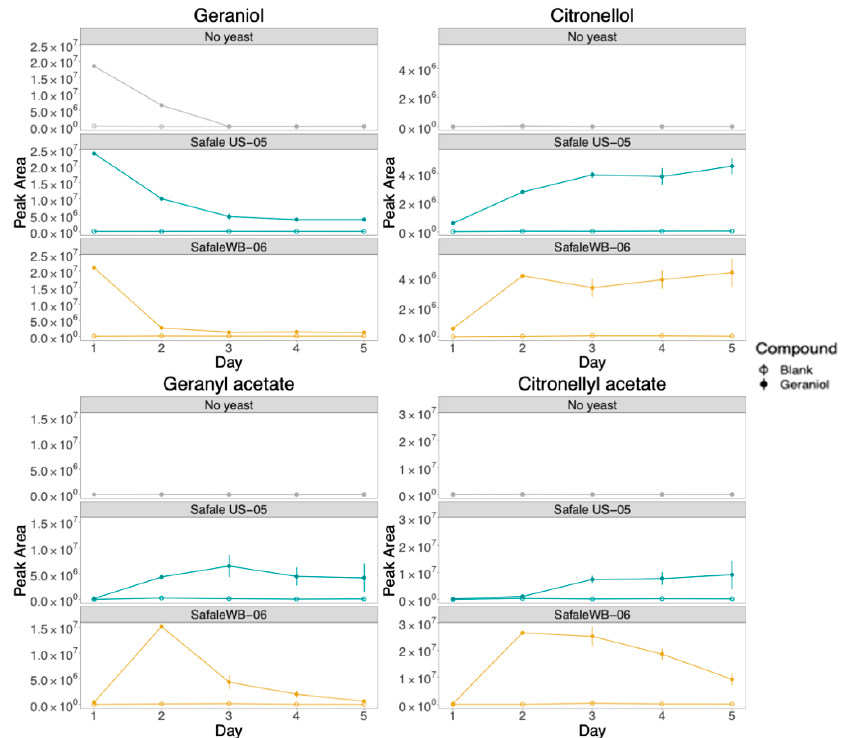
Figure 4. Time evolution of VOCs determined with SPME-GC/MS GC–MS. Quantification is given in the peak area detected under the curve, which can be quantitatively compared between the different measurements. Data presented as the mean peak area ± standard deviation of two replicates.